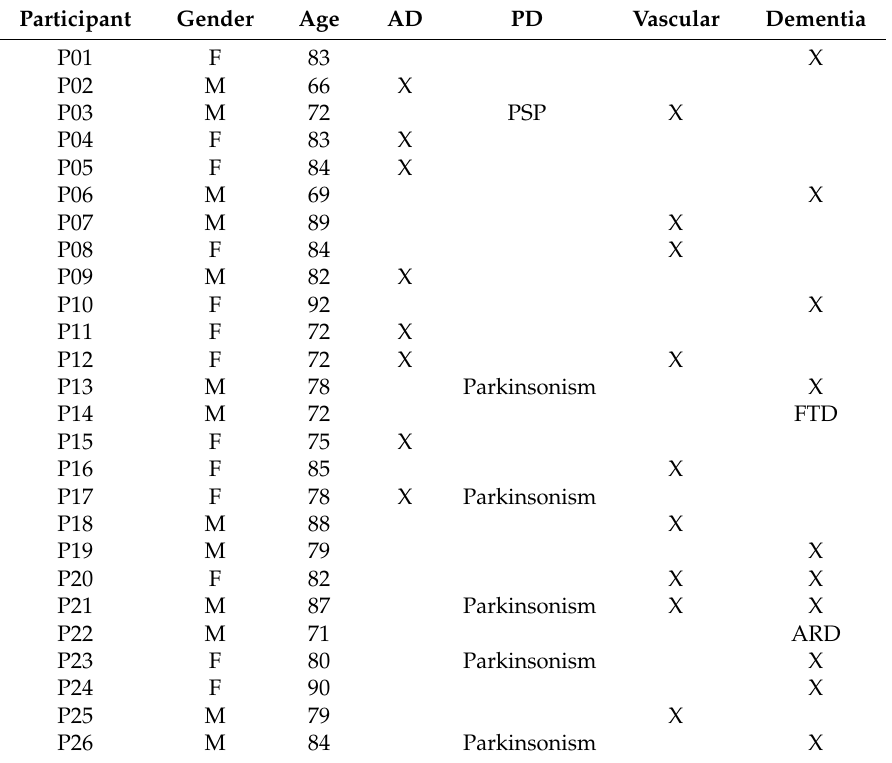
Table 1. Participant